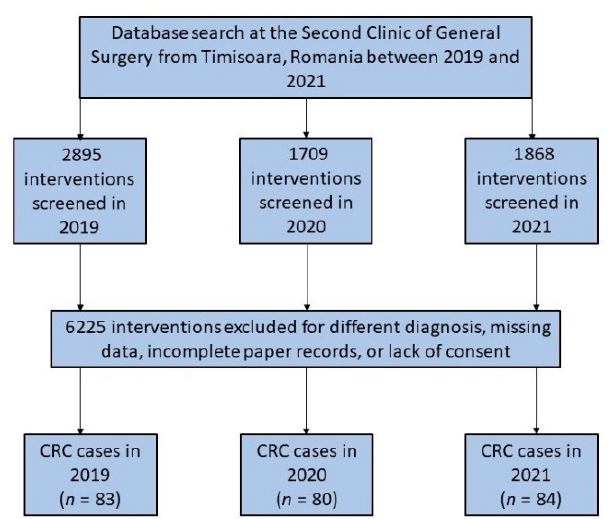
Figure 1. Diagram illustrating the inclusion of patients who had colorectal surgery over the 3-year research duration.